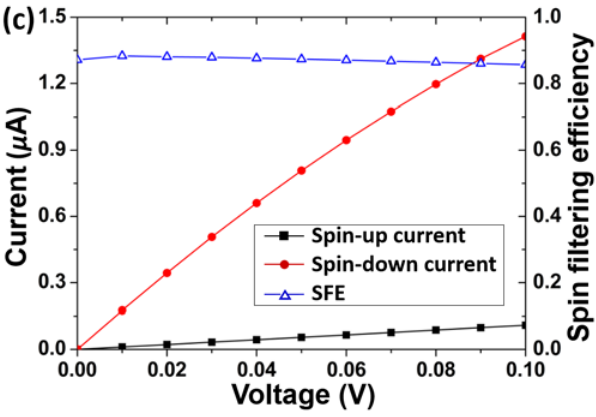
Figure 3. ( a ) Spin-polarized I - V curves of models M1 and M2; ( b ) Spin filtering efficiency (SFE) curves of models M1 and M2; ( c ) Spin-polarized I - V curves and SFE curve of model M2 at the lower bias voltages.